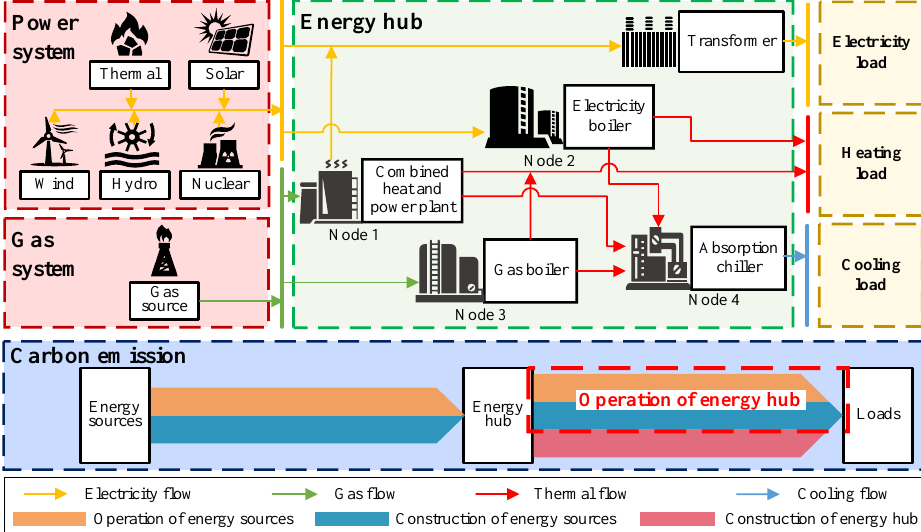
Figure 1. The framework of UMESs and their life-cycle carbon emissions.